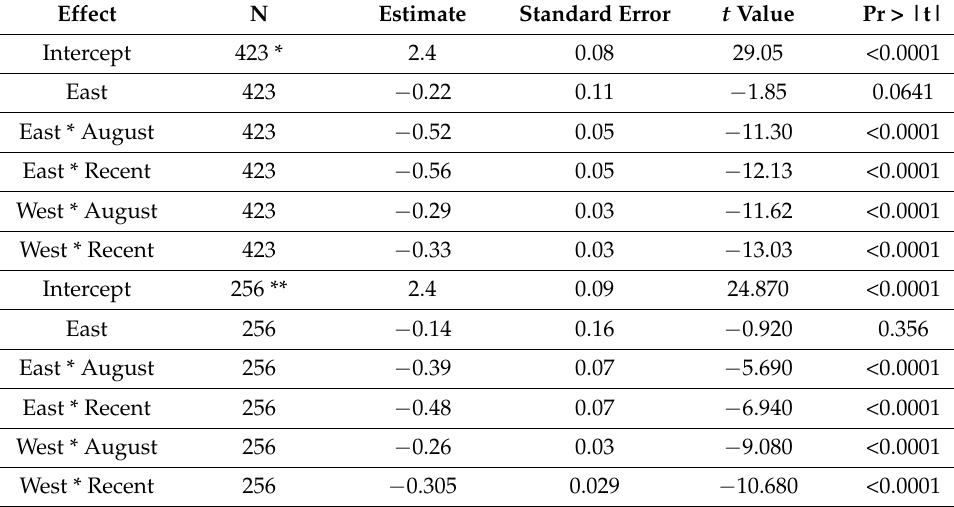
Table 3. Parameter estimates and associated